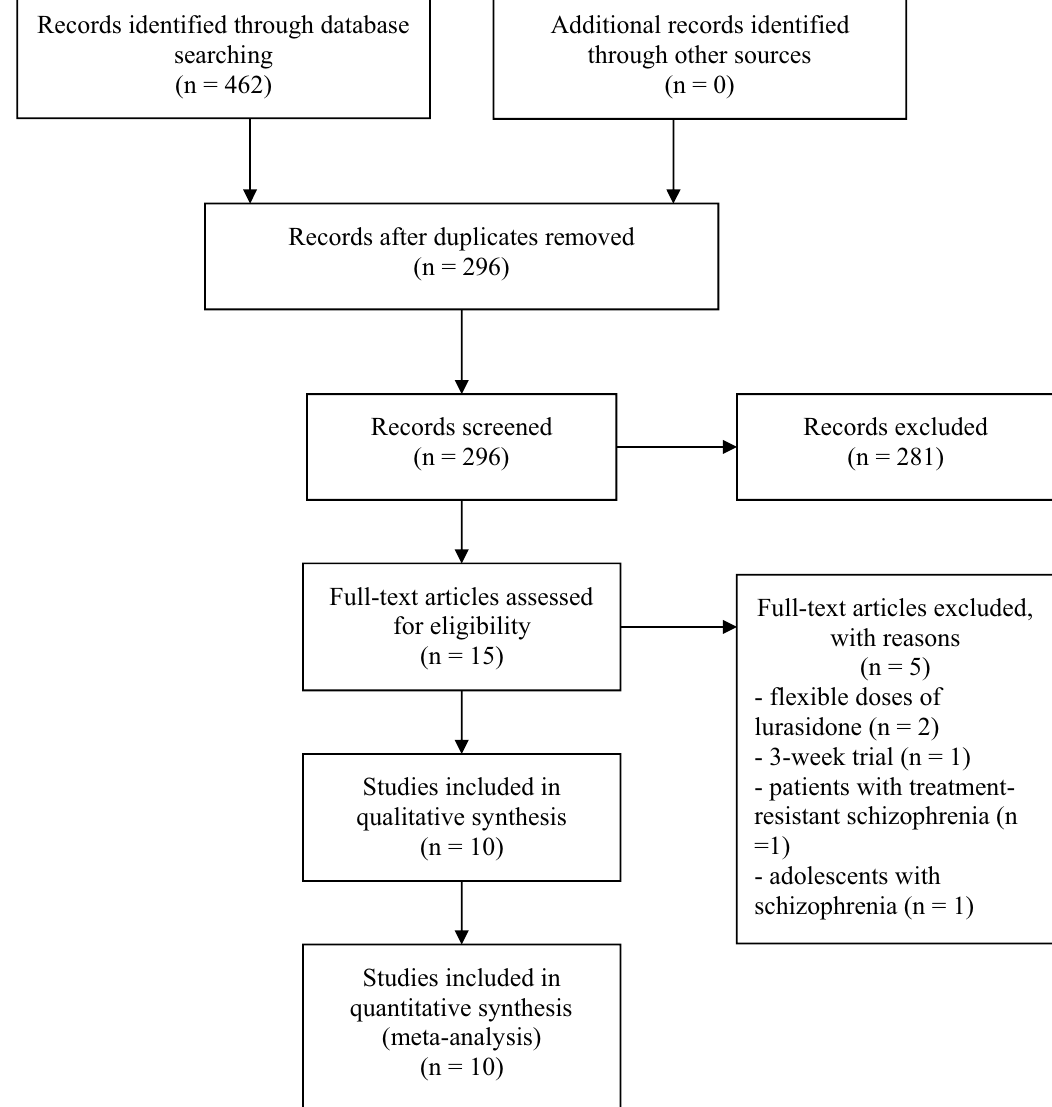
Figure 1. PRISMA flow diagram: records retrieved from database searches and trial inclusion in the systematic review and network meta-analysis of lurasidone doses for